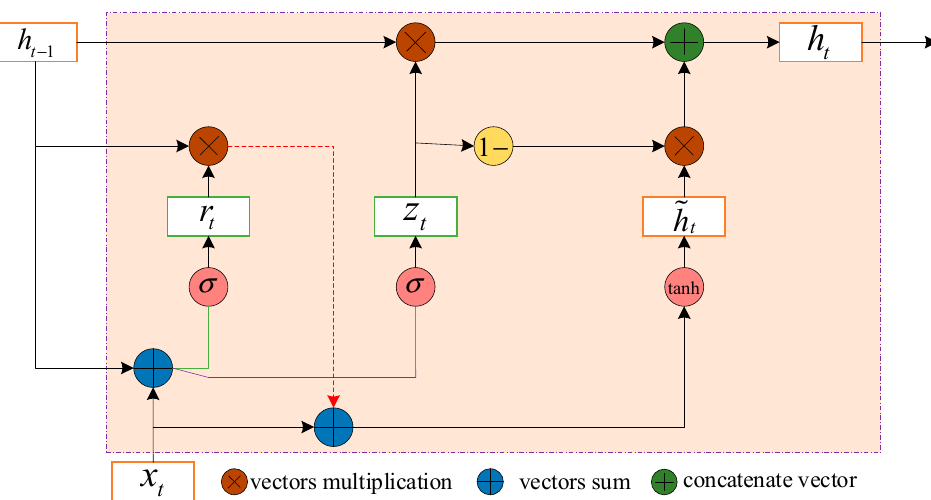
Figure 4. The unit structure of GRU.